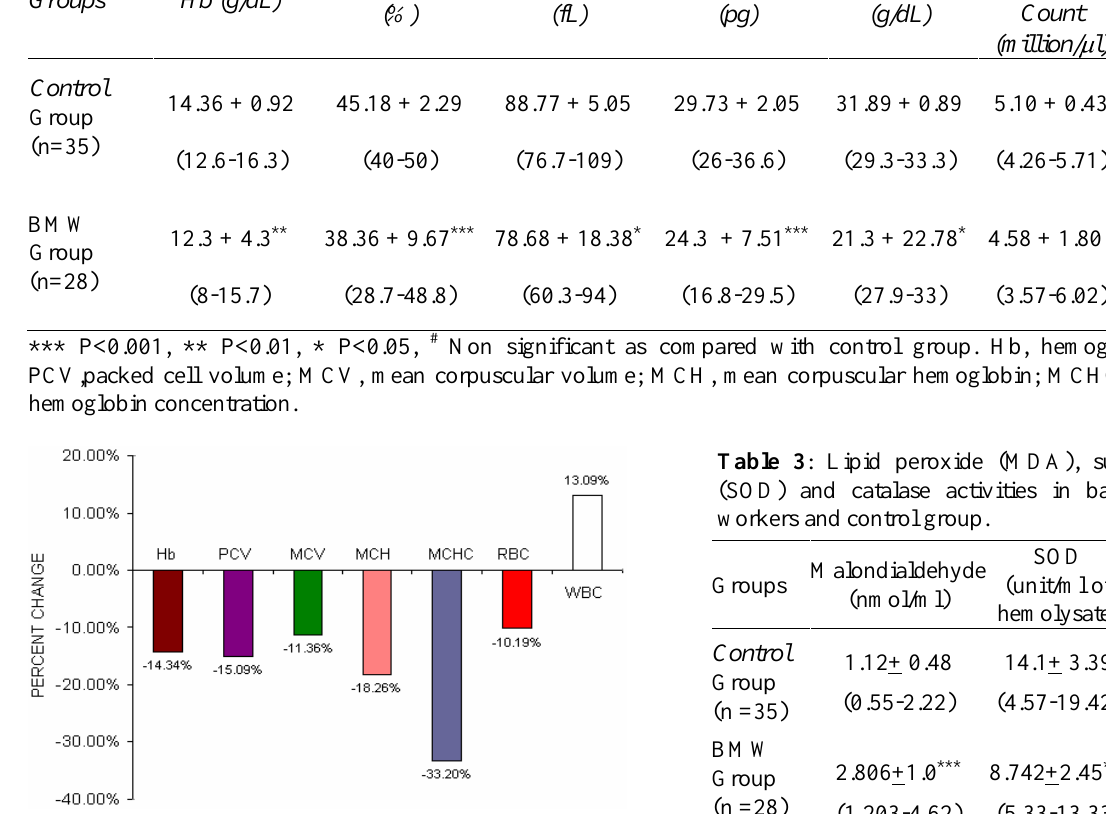
Figure 4: Percent change chart of hemoglobin concentration (Hb), packed cell volume (PCV), mean corpuscular volume (MCV), mean corpuscular haemoglobin (MCH), mean corpuscular hemoglobin concentration (MCHC), total erythrocyte count (RBC) and total leukocytes count of lead exposed battery manufacturing workers (BMW) group of western Maharashtra (India) with respect to control group.